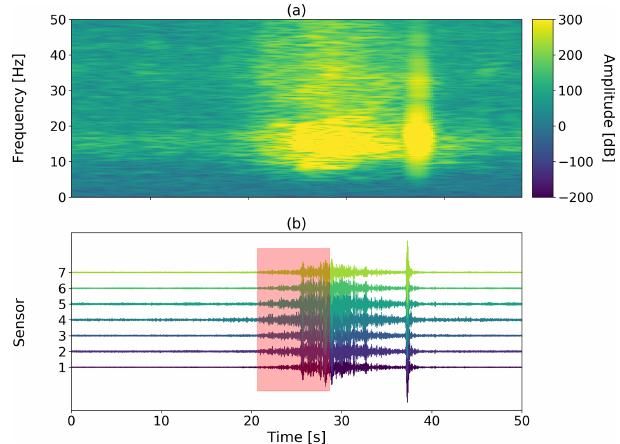
Figure 7. The event used for training the HMM. (a) Stacked spec- trogram of all seven sensors. (b) Seismic waveform for each indi- vidual sensor (colors). The red area highlights the part of the signal used as the training event for the HMM.